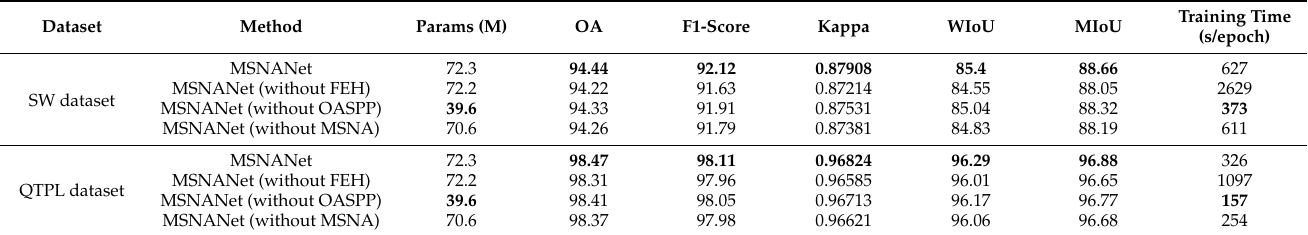
Table 5. Quantitative analysis of ablation study. Training time indicates the training time of each epoch. Bold numbers indicate the best